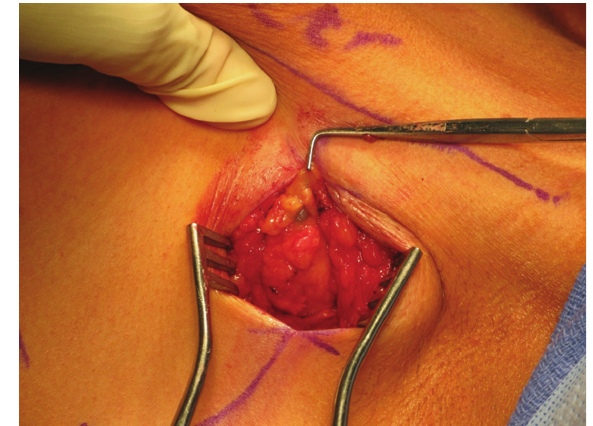
Figure 3: Axillary sentinel lymph node biopsy.